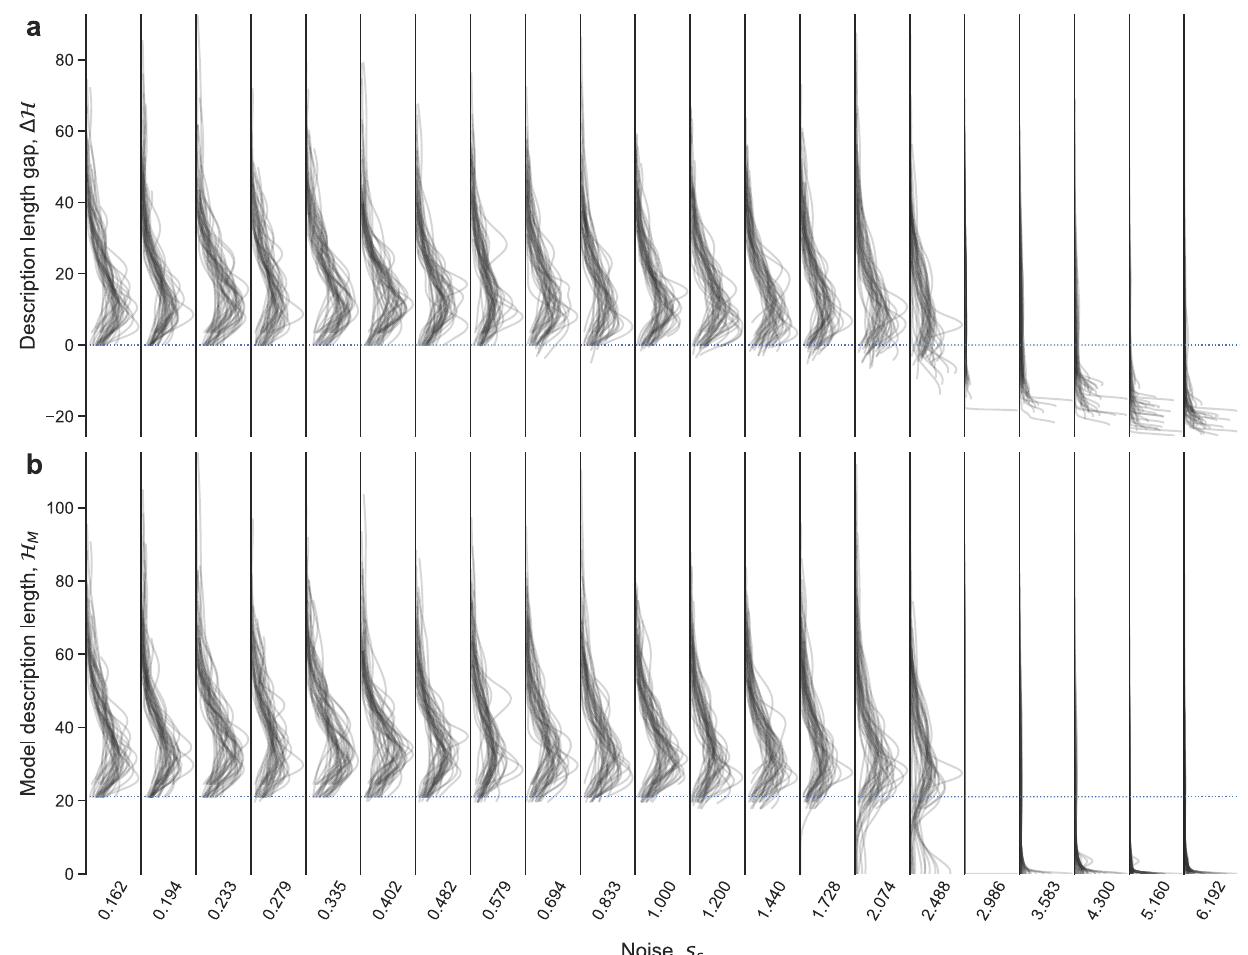
Fig.2|Phenomenologyofthelearnabilitytransition. Using “ Model1 ” inFig.1,we generate 40 different datasets D (with N =100) for each observation noise s ϵ . As before,thevaluesoftheindependentvariables x 1 and x 2 aregenerateduniformlyat random in [ − 2,2]. For each dataset, we sample models from the posterior p ( m ∣ D ) and obtain the distribution of certain properties of the sampled models. a Distribution of description length gaps Δ H ð m Þ = H ð m Þ(cid:2) H ð m * Þ ; each line corre- sponds to a different dataset D . The true generating model has Δ H ð m Þ =0, indi- cated by a horizontal dashed line. Positive gaps correspond to models m that are